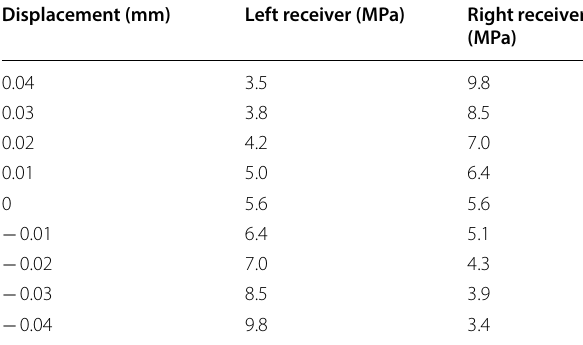
Table 6 Experimental